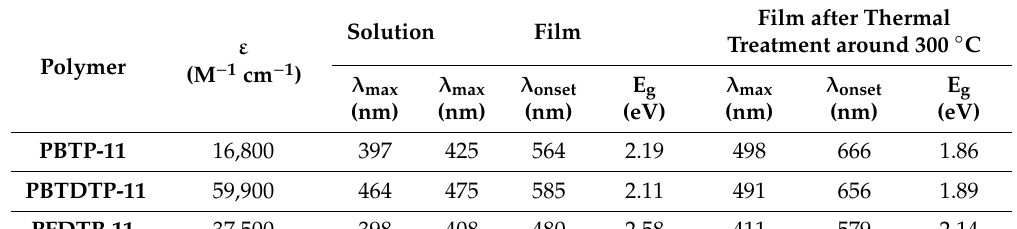
Figure 2. Normalized UV-vis absorption spectra of PBTP-11, PBTDTP-11 and PFDTP-11 after thermal treatment around 300 °C for 1 h . Table 2. Data and optical band gaps of the polymers .